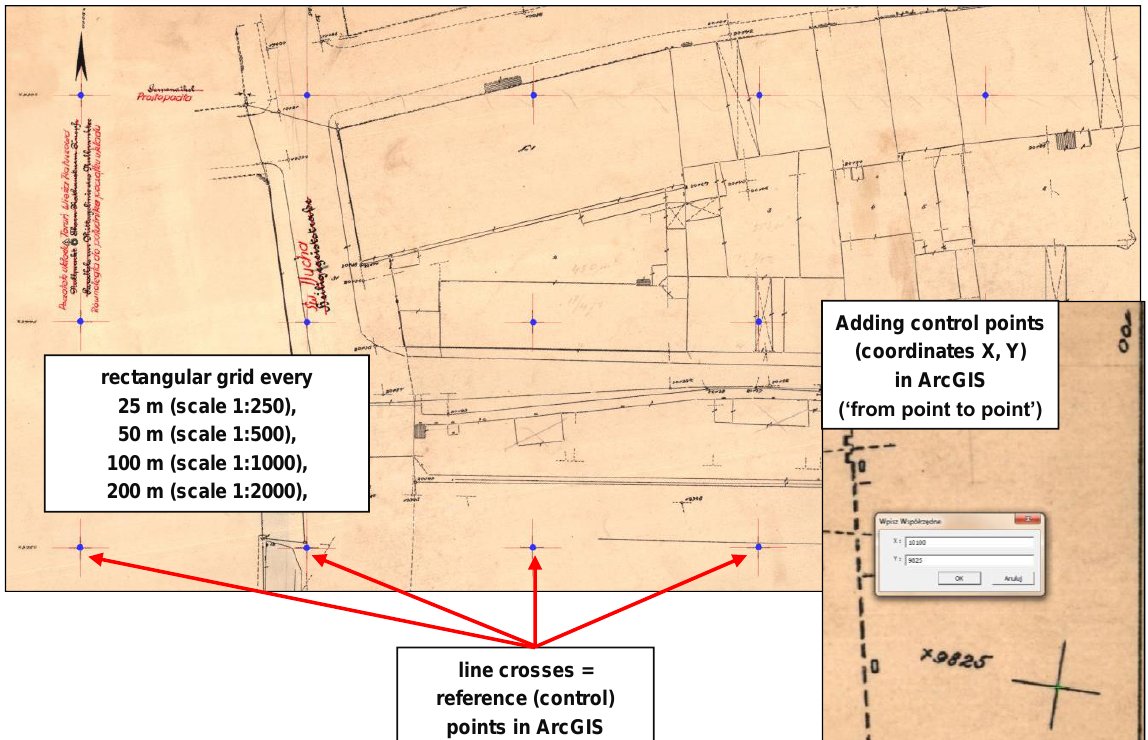
Figure 4. Line crosses as reference (control) points used in the calibration and rectification process of the cadastre sheets. Source: Gemarkungskarte der Stadt Thorn, Blatt 37, State Archives in Toruń.